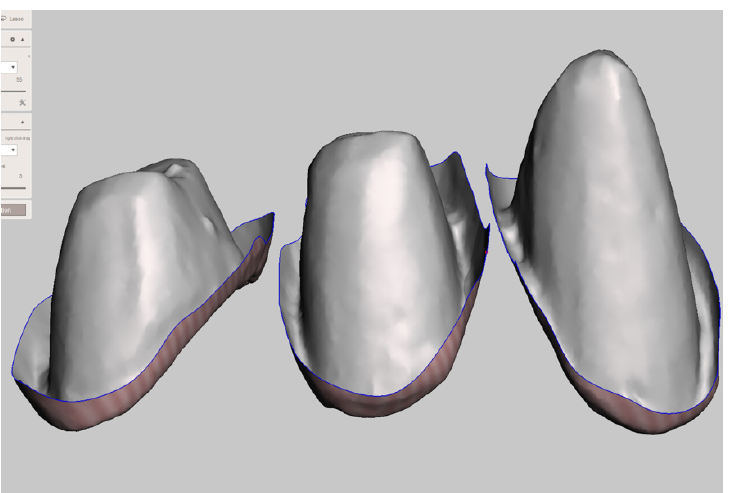
Figure 9. Manipulation of the inside area of the provisional restoration after deleting all unnecessary areas.